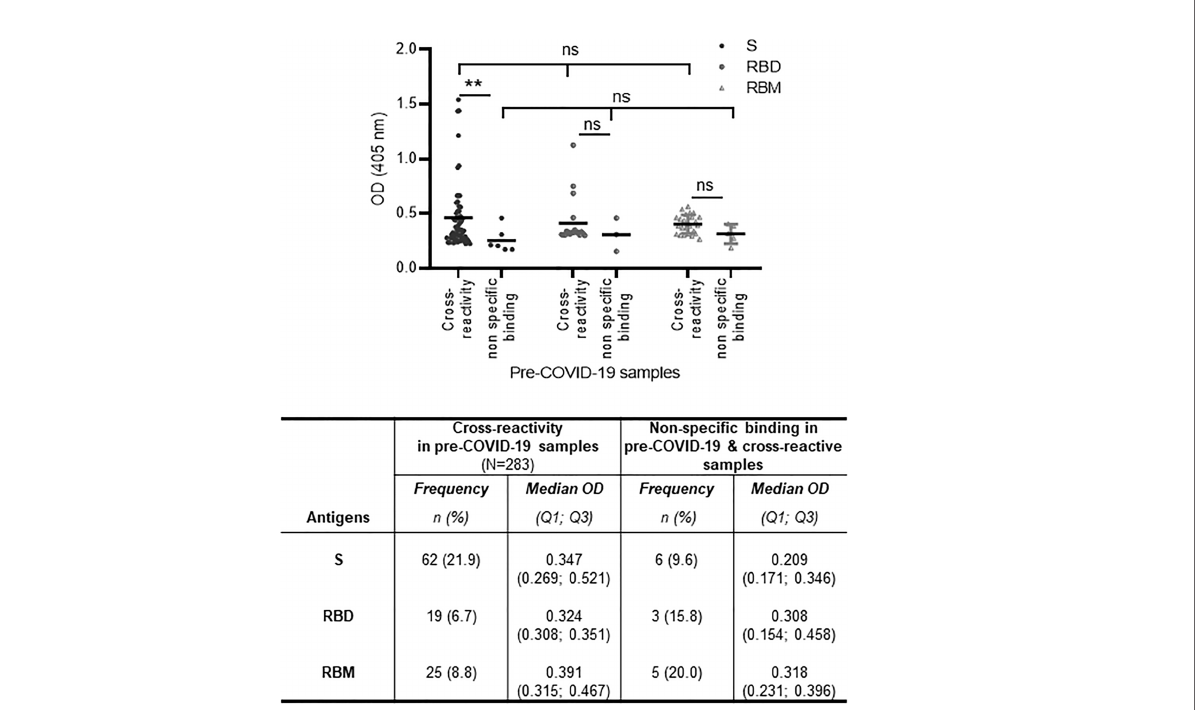
FIGURE 3 | Cross-reactivity and non-speci fi c binding against S, receptor-binding domain (RBD), and receptor-binding motif (RBM) in pre-COVID-19 and endemic malaria samples. The cross-reactive antibody levels (mean optical density (OD) shown as a horizontal black line in the dot plots) for S, RBD, and RBM were demonstrably higher than in non-speci fi c binding antibody levels; this was signi fi cant for S ( p < 0.01). The table shows the number and proportion (frequency) of samples showing cross-reactions or non-speci fi c binding for S, RBD, and RBM. N, total number of pre-COVID-19 samples; n, number of cross-reactive or non-